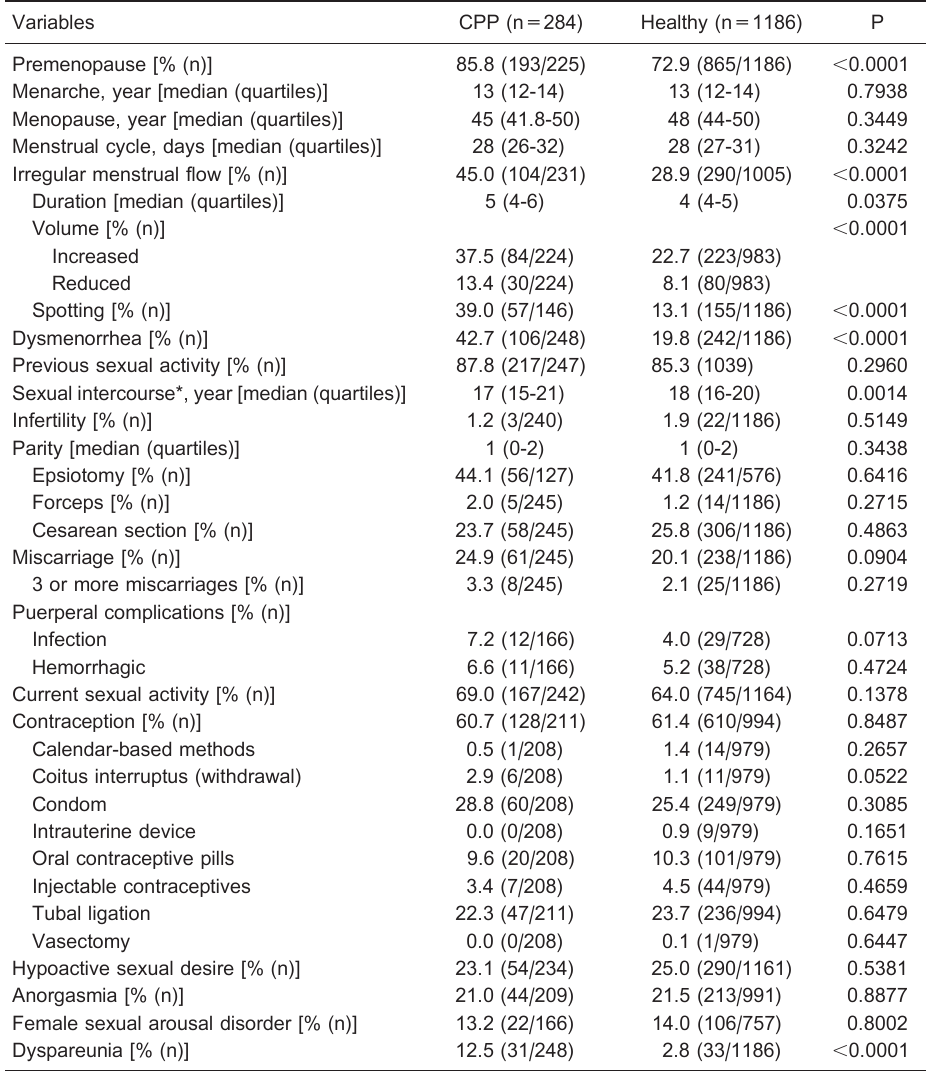
Table 2. Characteristics of menstrual, sexual and obstetric history of women with chronic pelvic pain (CPP) and healthy women.